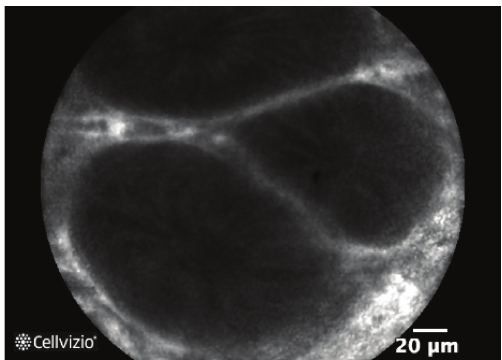
Figure 3: p-CLE fluorescein sodium 10% imaging of vessel architecture in ulcerative colitis: preserved hexagonal, honeycomb appearance with slightly dilated